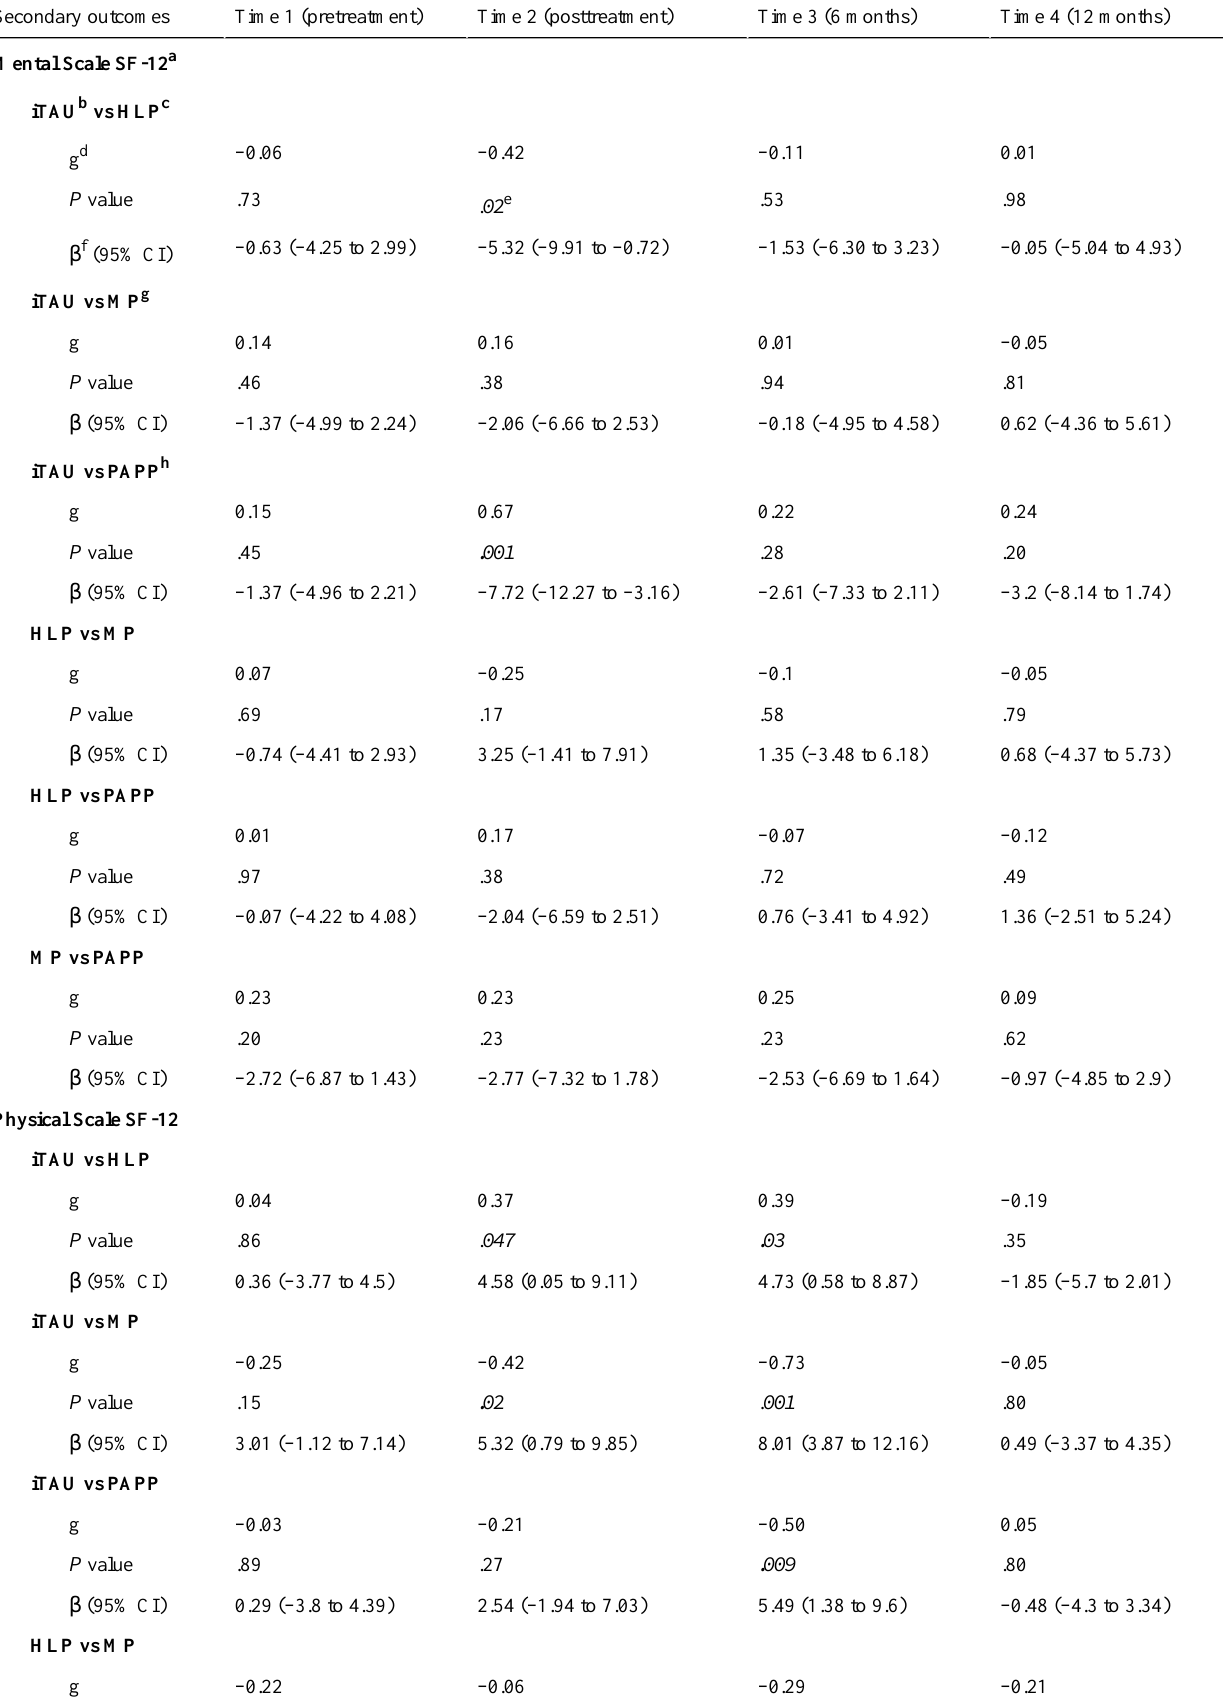
Table 5. Short-Form Health Survey-12 (Mental and Physical) outcome analysis with imputed data (N=221): intervention comparisons along the